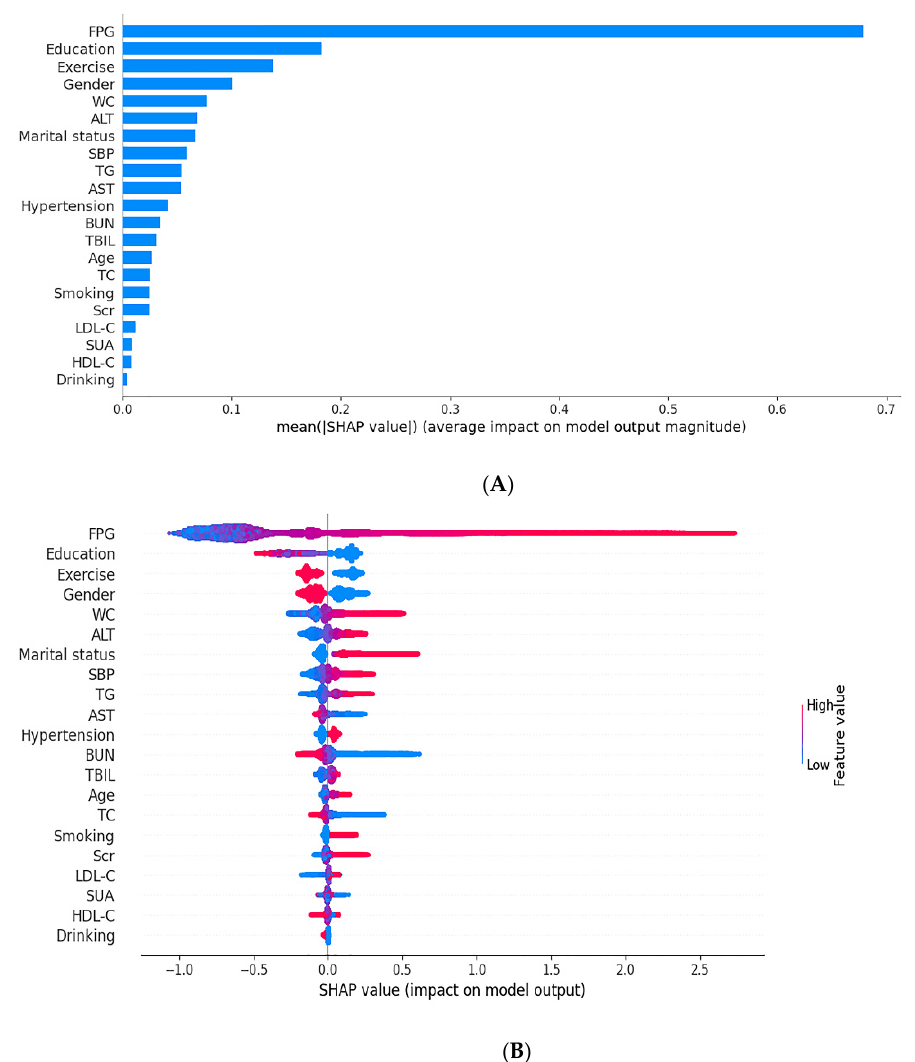
Figure 4. The interpretations for the XGBoost model. ( A ): The feature importance ranking by the